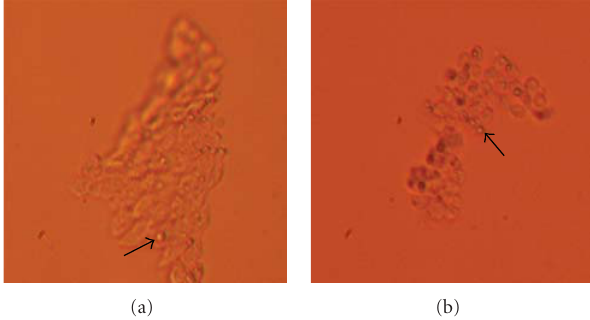
Figure 2: Small round cells (arrows)—putative stem cells with diameters of 2 to 4 μ m in the ovarian surface epithelium scrapings. (a, b) Among the epithelial cells. (Inverted microscope, Ho ff man illumination, magnifications 100 and